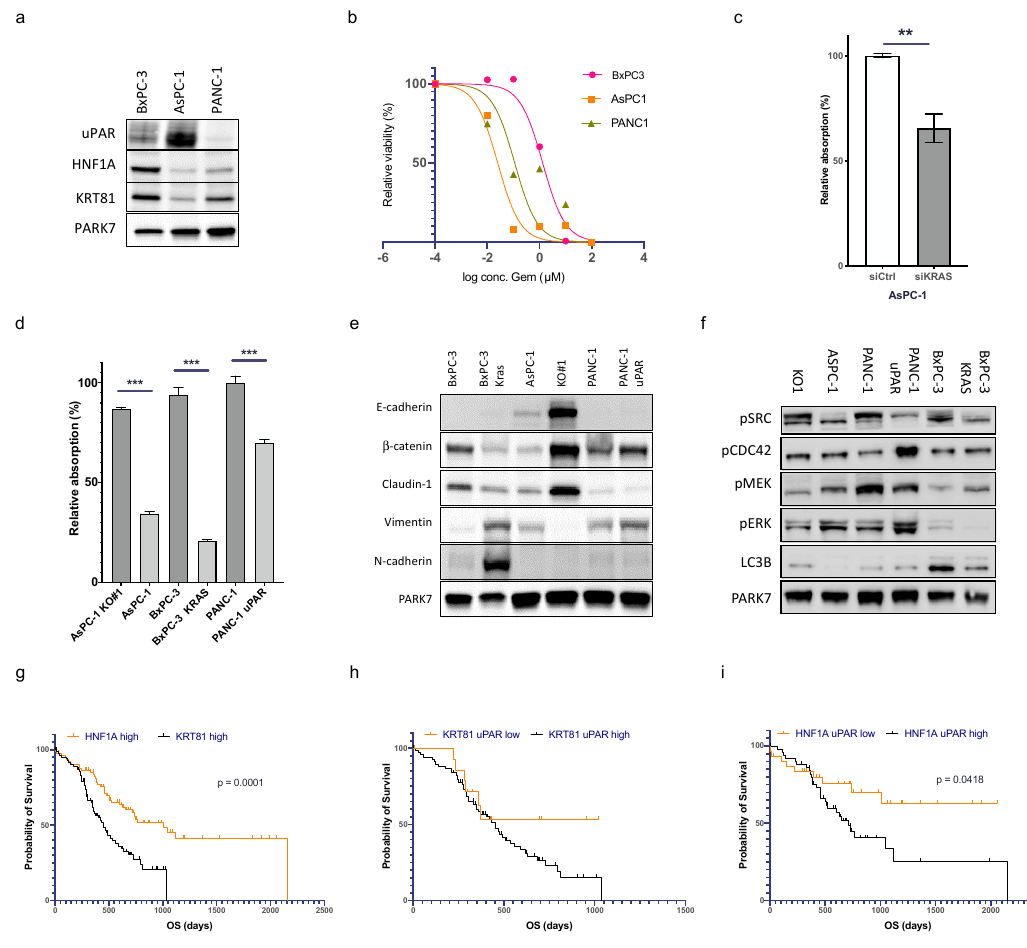
Figure 4. uPAR and mutated KRAS cooperate in maintaining a mesenchymal phenotype that also regulates gemcitabine sensitivity. ( a ) Immunoblot showing uPAR, HNF1A, and KRT81 expression in BxPC-3, AsPC-1, and PANC-1. Uncropped Western blot images available in Supplementary File S1 ( b ) IC50 of gemcitabine treatment (0–100 µ M, 72 h) in BxPC-3 (1.323 µ M), AsPC-1 (0.025 µ M),